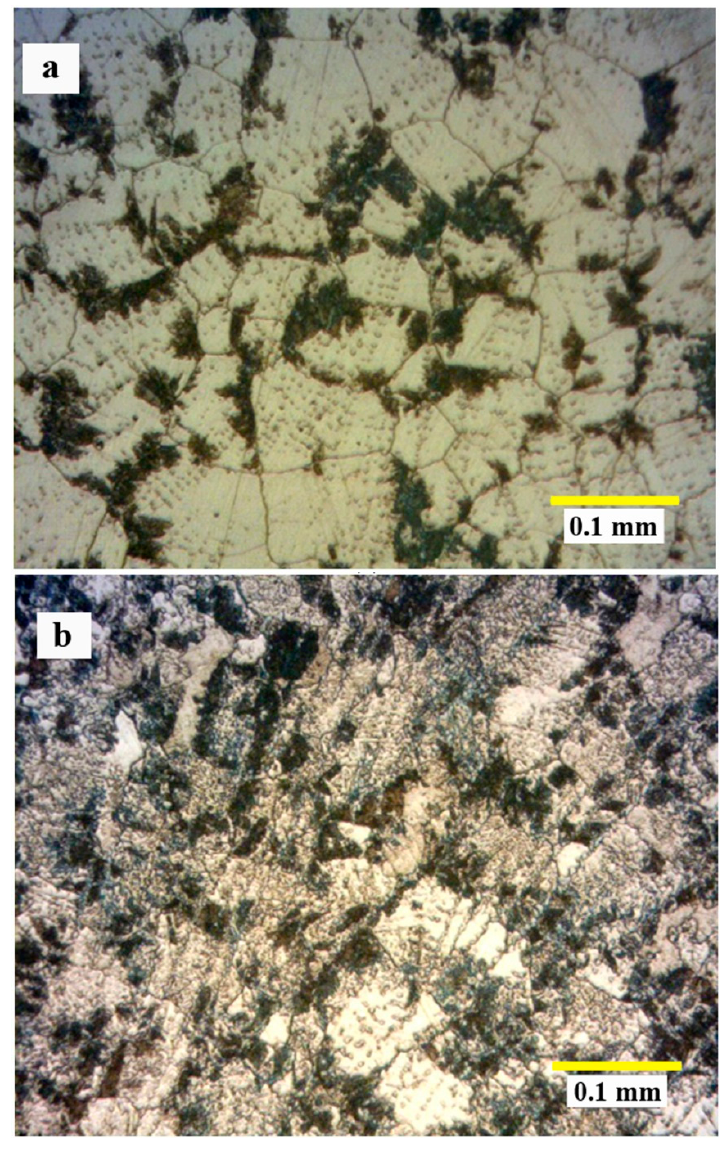
Figure 7. Microstructure of the sample solution treated at 1200 ° C for 1 h and aged at 850 ° C for ( a ) 24 h and ( b ) 48 h.